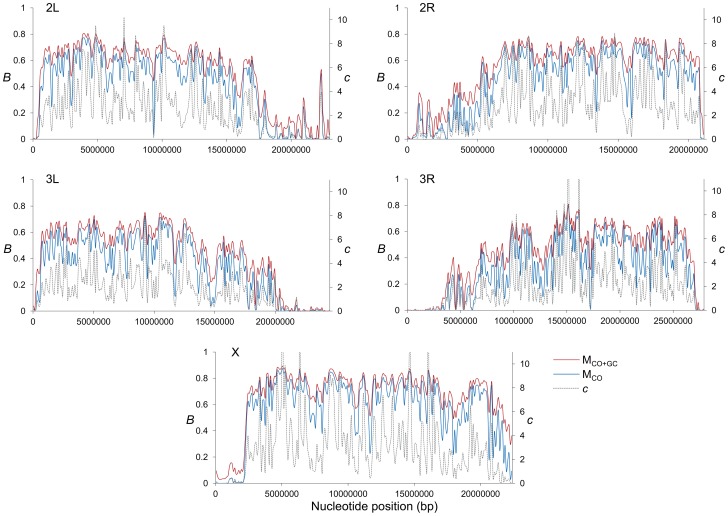
High-resolution distribution of BGS effects across the D. melanogaster genome.Estimates of BGS effects are measured as B and shown along each chromosome arm for 100-kb adjacent windows. Red and blue lines depict estimates of B based on models MLN,StdMut,CO+GC (MCO+GC) and MLN,StdMut,CO (MCO), respectively. Grey dashed lines show the distribution of crossover rates (c), measured as centimorgans (cM) per megabase (Mb) per female meiosis (see [31] for details).